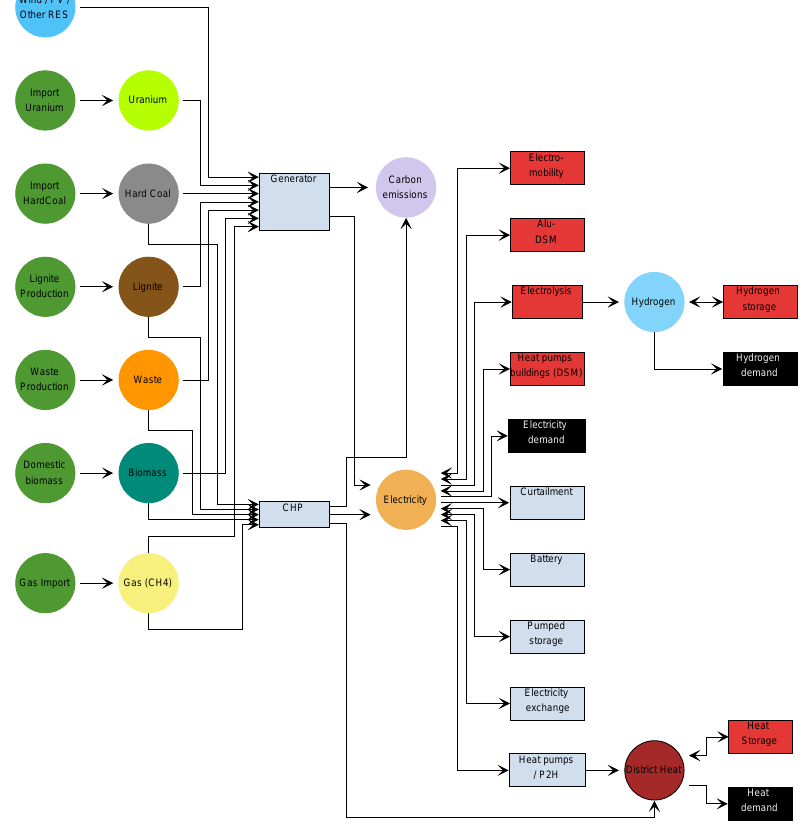
Figure 1. Components considered in the dispatch model and their inter-linkages. Flexibilities are highlighted in